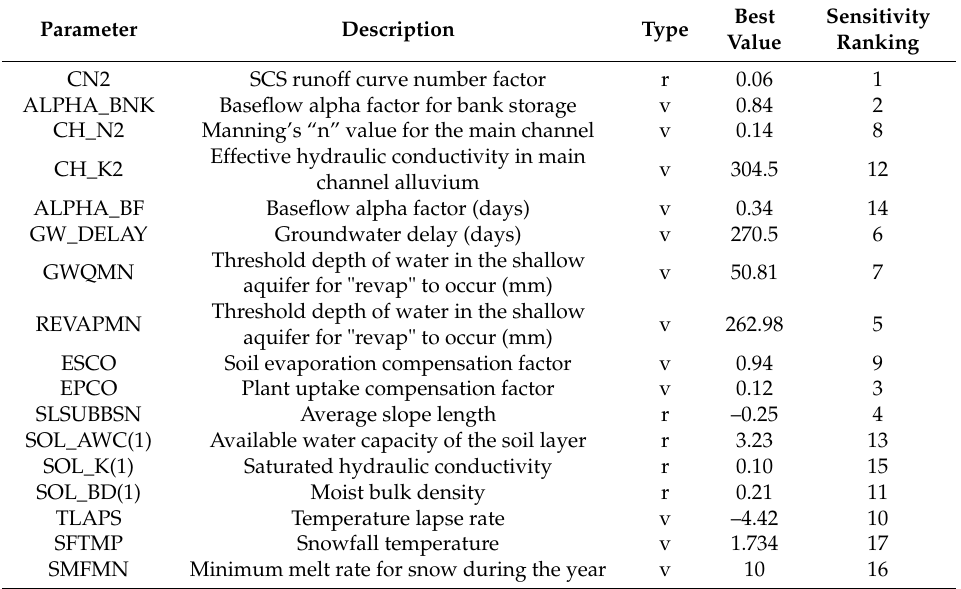
Table 4. The calibrated parameter values selected for the SWAT model at Ertan